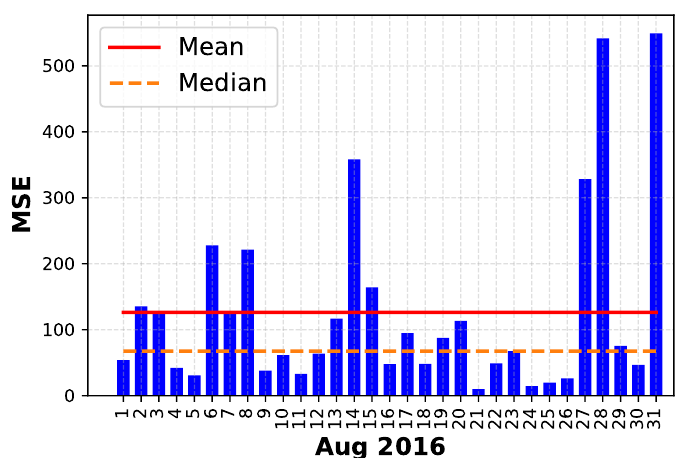
Figure 18. MSE performance of the three-layer ANN model for the month of August 2016.